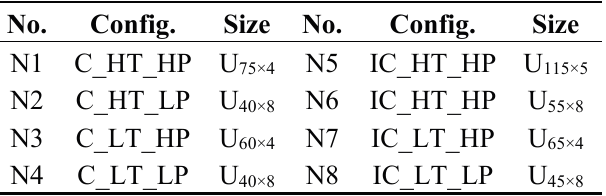
Table 7. The utilization matrix